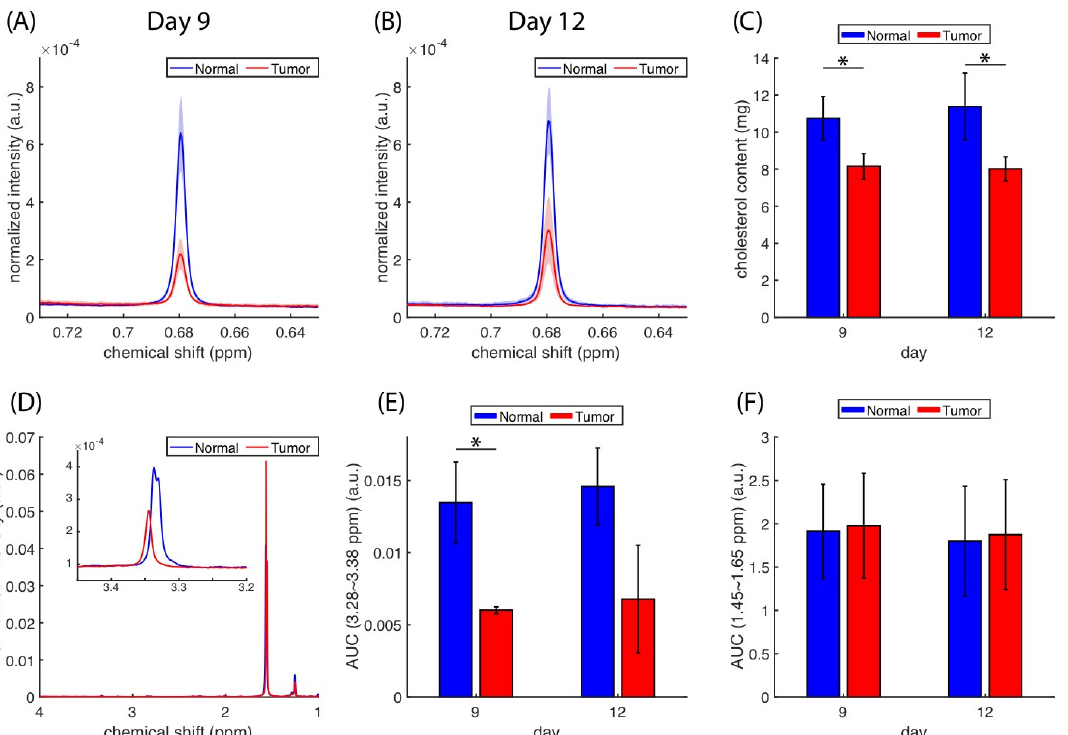
Figure 5. 1 H NMR of cholesterol methyl (0.68 ppm) from lipid extracts of normal and tumorous brain tissues (N = 3) on days nine ( A ) and 12 ( B ) and their cholesterol content ( C ) as quantified using AUCs of methyl shown in ( A , B ). ( D ) The choline methyls from the phosphatidylcholines (~3.35 ppm) and alkyl hydrogens (~1.5 ppm) can be identified in the 1 H spectra. The AUCs between 3.28 to 3.38 ppm and 1.45 to 1.55 ppm were used to estimate the relative amounts of phosphatidylcholine ( E ) and total lipid ( F ). (* p < 0.05).